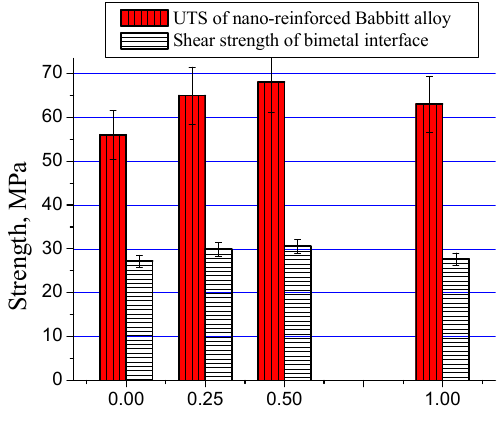
Figure 10. The average tensile strength values of nanocomposites containing alumina nanoparticles and average shear strength values of corresponding bimetallic interfaces.